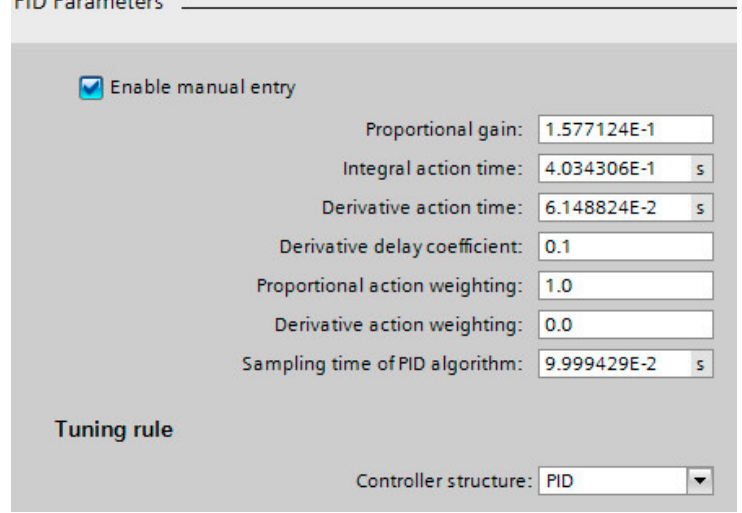
Figure 4. Configuration parameters of the PID controller.